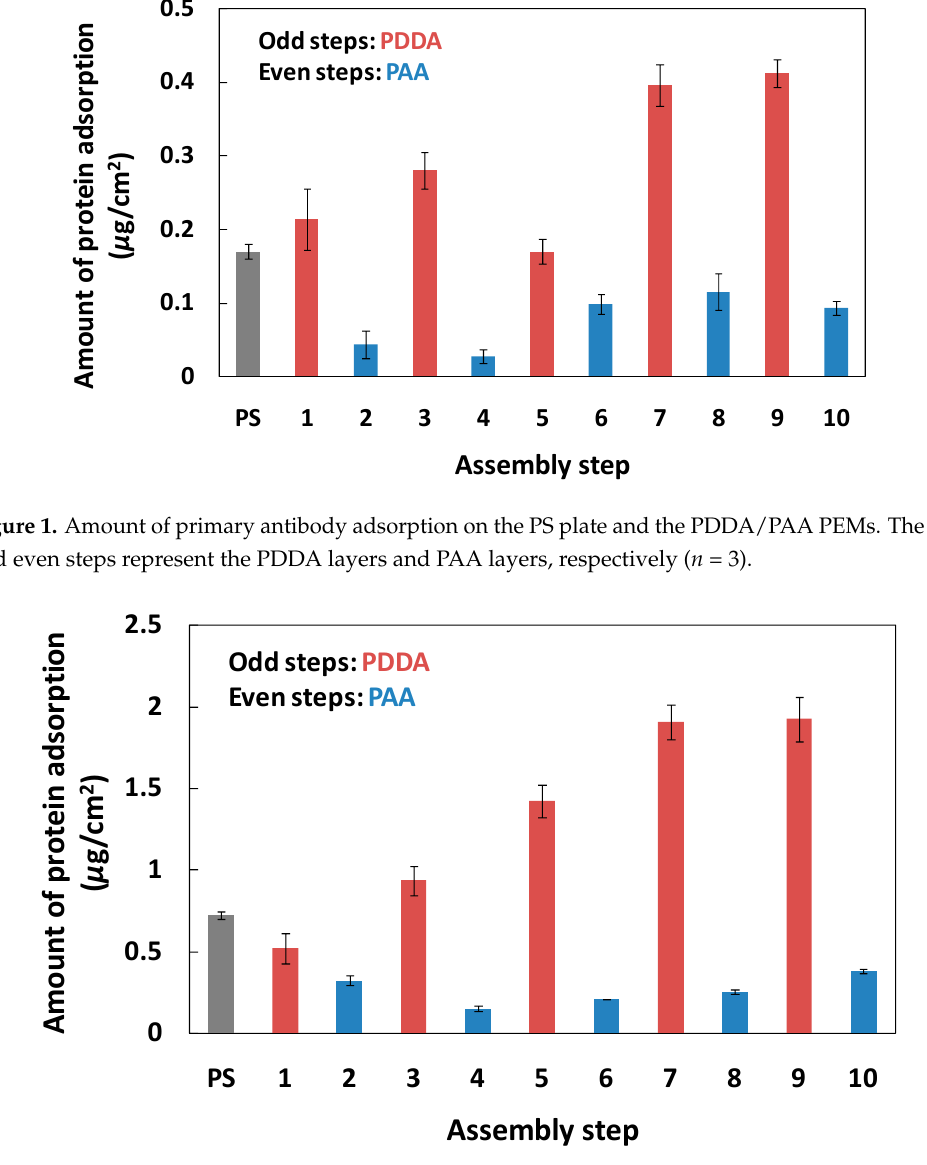
Figure 2. Amount of OVA adsorption on the PS plate and the PDDA/PAA PEMs. The odd and even steps represent the PDDA layers and PAA layers, respectively ( n = 3).